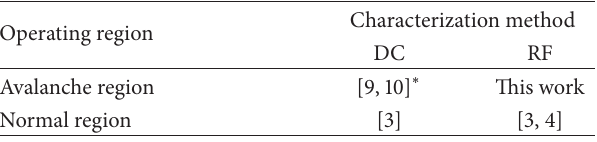
Table 1: Comparison between extracted and calculated breakdown noise spectral density at 𝑉 BE = 1.1 V and 𝑉 CE = 3.6 V for different sized SiGe